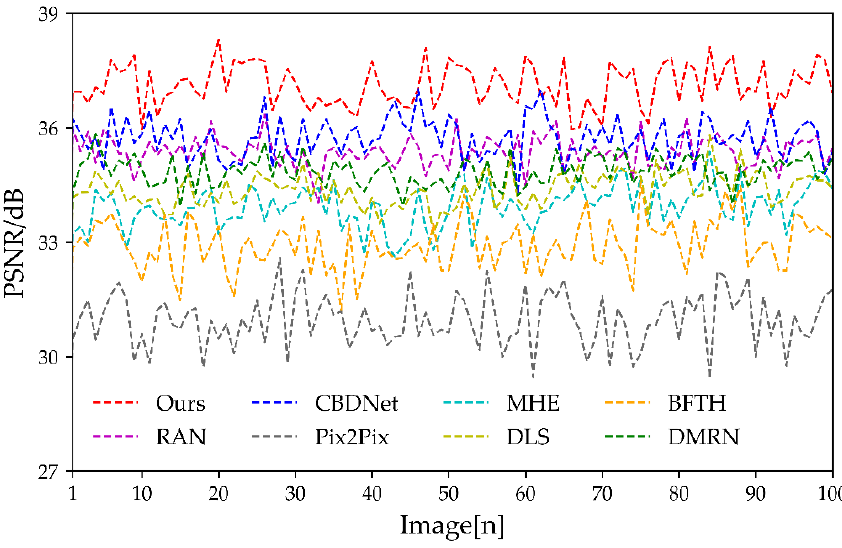
Figure 23. PSNR of test dataset.